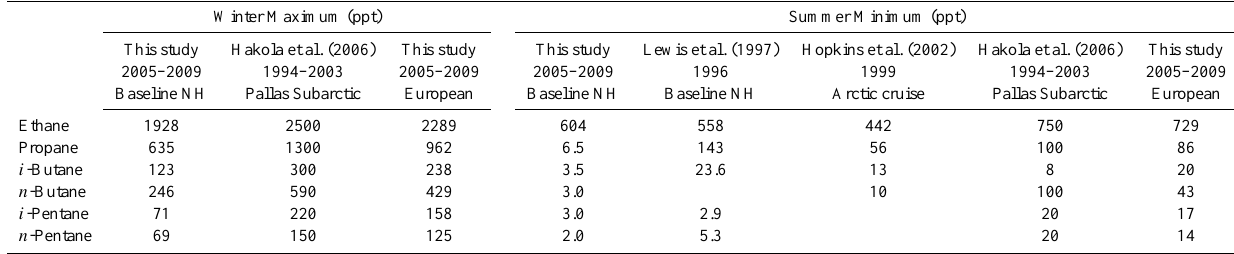
Table 4. Monthly average NMHC mole fractions for yearly maxima and yearly minima (in ppt) at Mace Head during the arrival of baseline northern hemispheric air masses with NMHC measurements from other remote northern hemispheric stations.